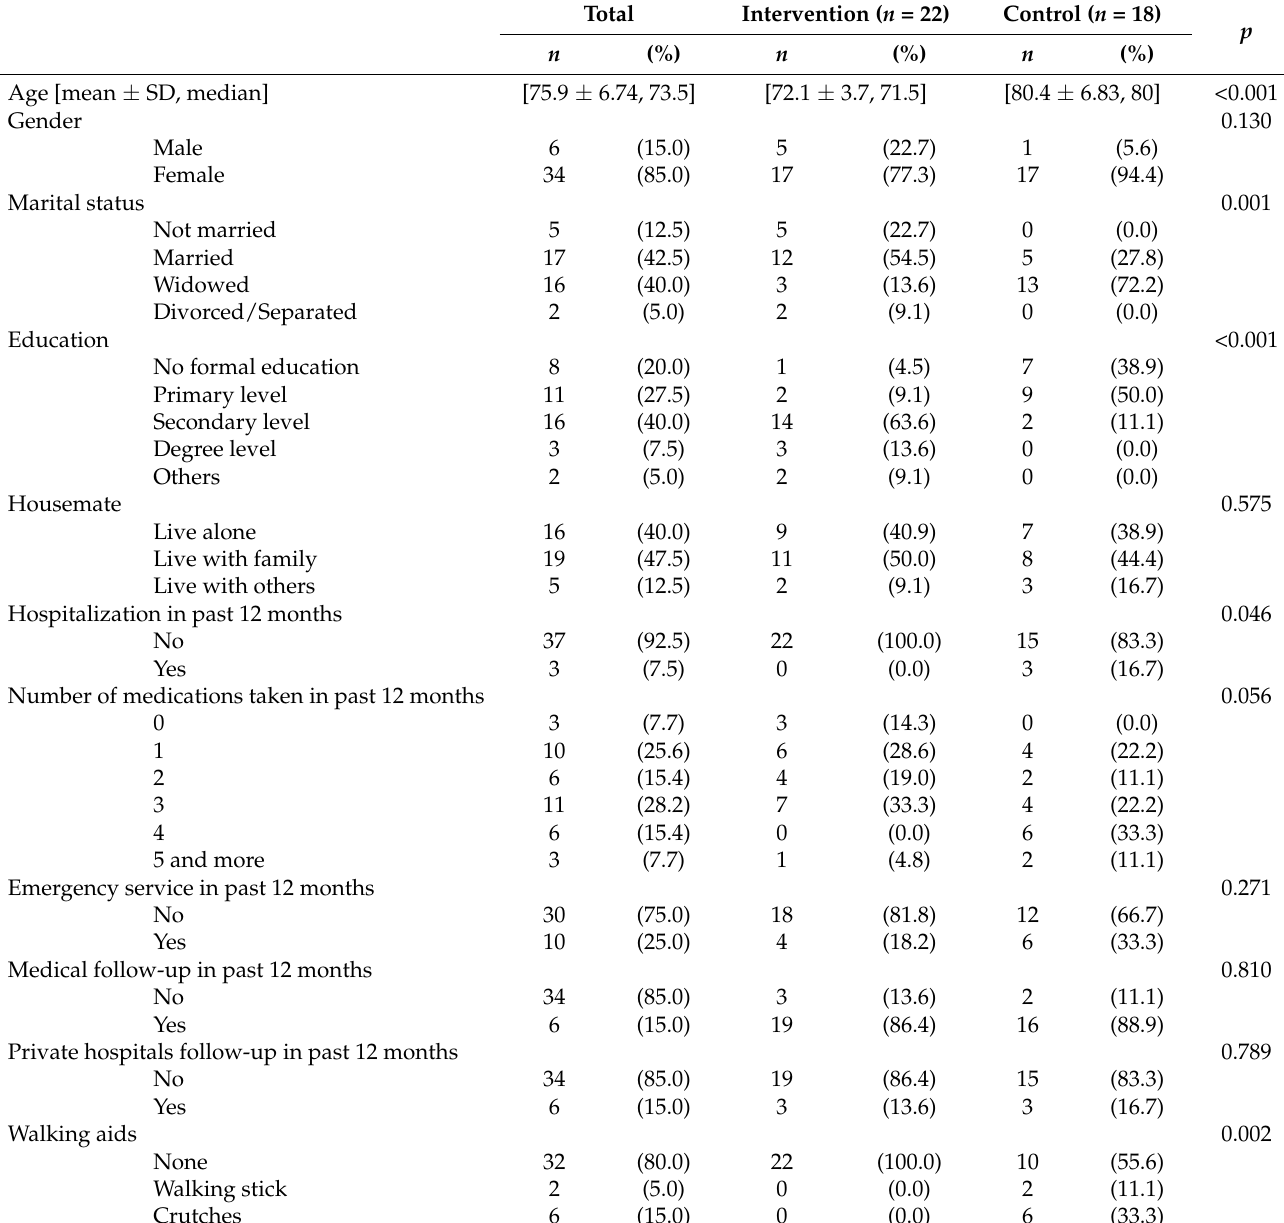
Table 1. Demographic characteristics of the